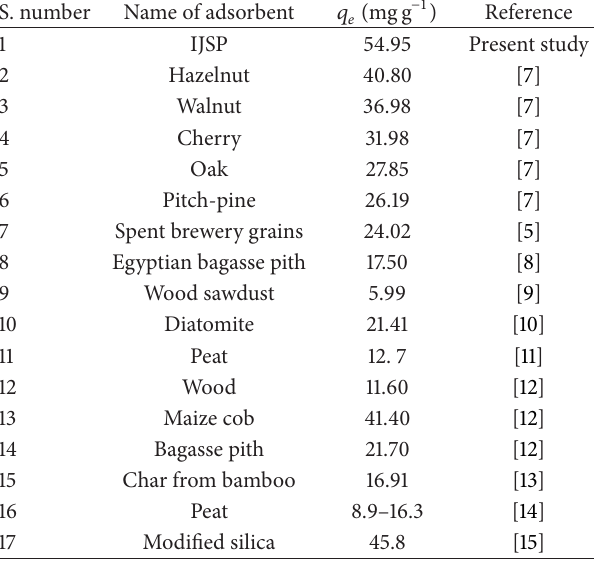
Table 7: Adsorption capacities of AB25 on various